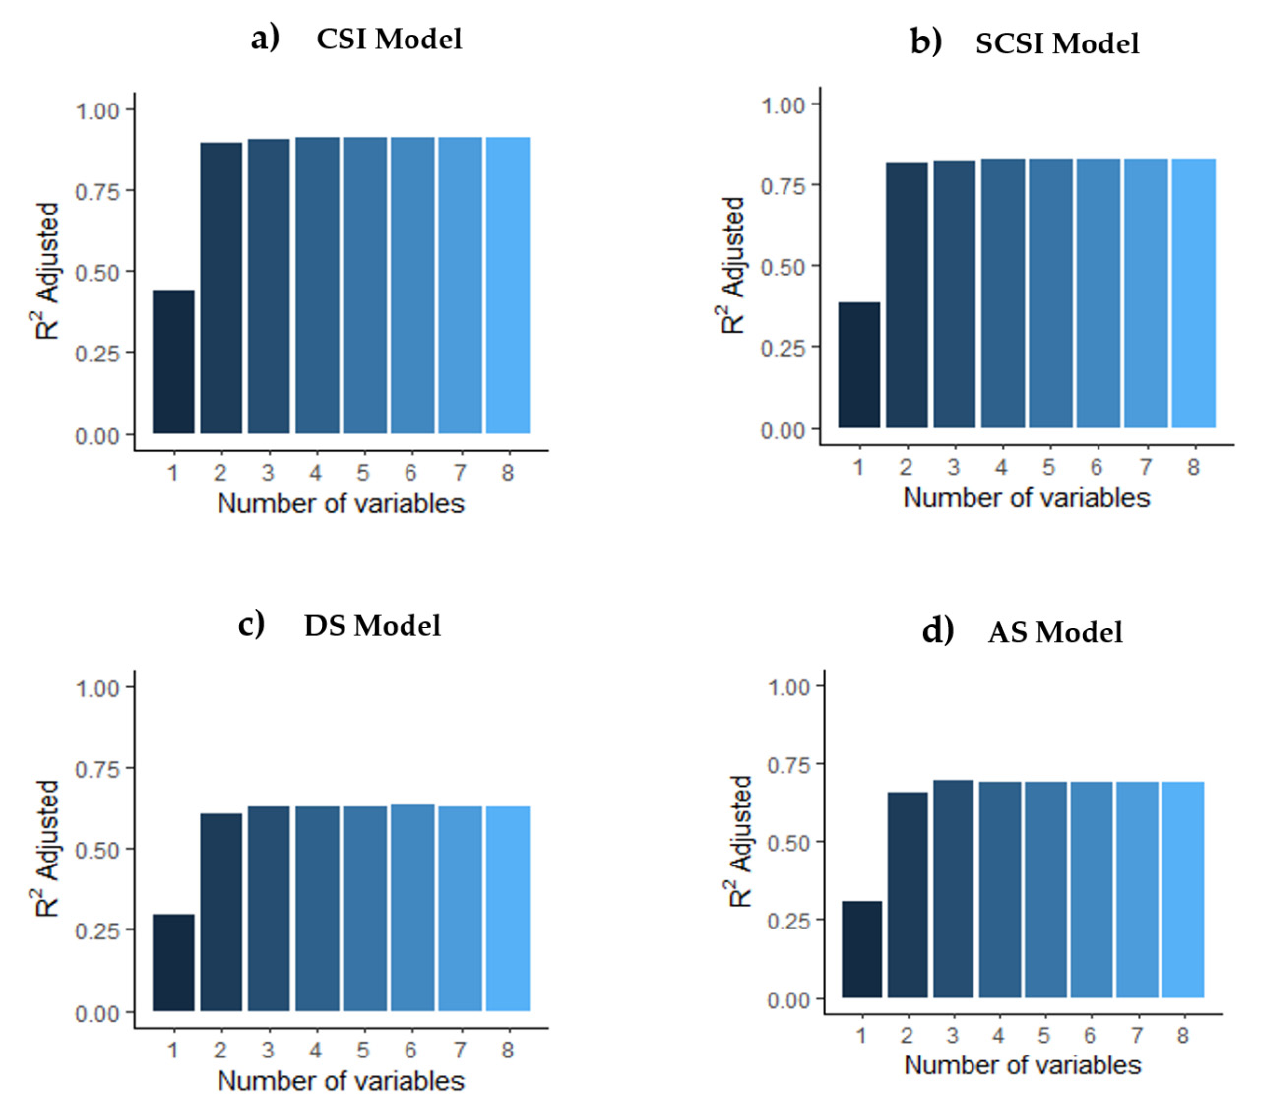
Figure 17. Best subset selection algorithm of number of variables for all Kt sections. The number of variables versus the adjusted R2 is shown in: ( a ) for the clear sky model CSI, ( b ) for the semi-clear sky model SCSI, ( c ) cloudy sky model DSI and ( d ) all sky conditions model AS.